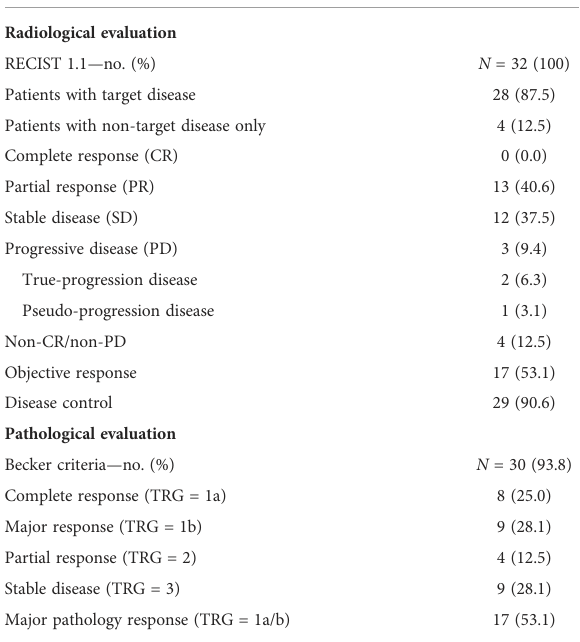
TABLE 3 Tumor response. Tumor